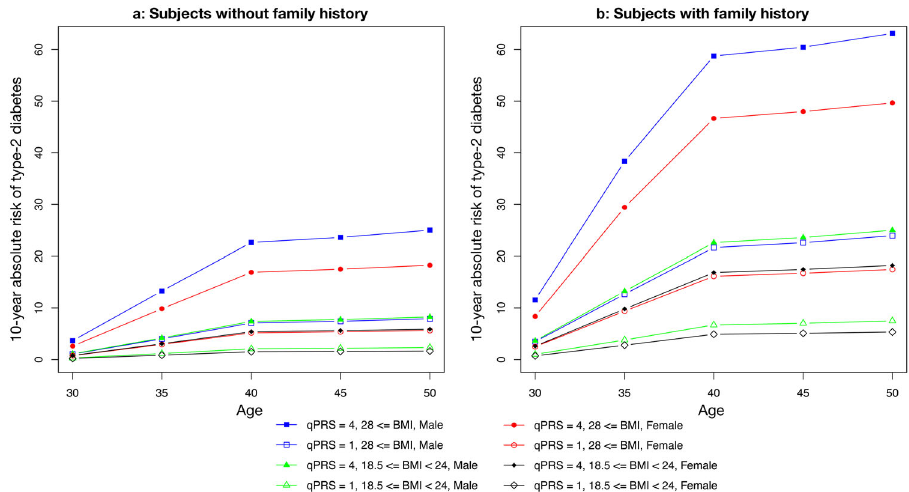
Fig. 4 10-year absolute risk of type 2 diabetes for subjects without and with a family history of type 2 diabetes by age and risk pro fi les. a Subjects without a family history. b Subjects with